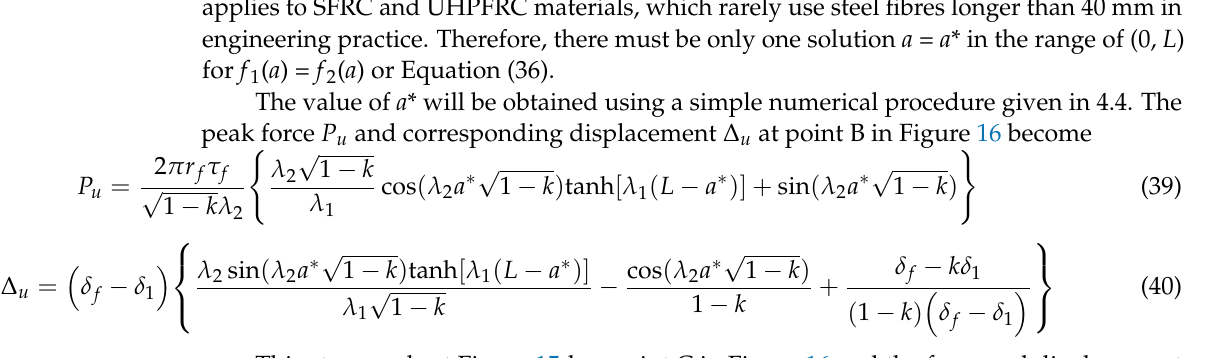
This stage ends at Figure 15d or point C in Figure 16 and the force and displacement can be calculated by substituting a = L into Equation (32) and Equation (33),